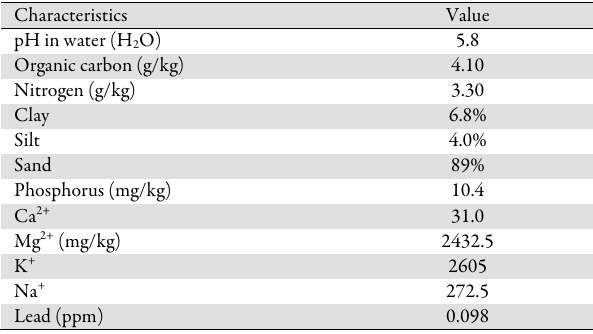
Table 2. Bioaccumulation and translocation factors for Momordica charantia Lead concentration